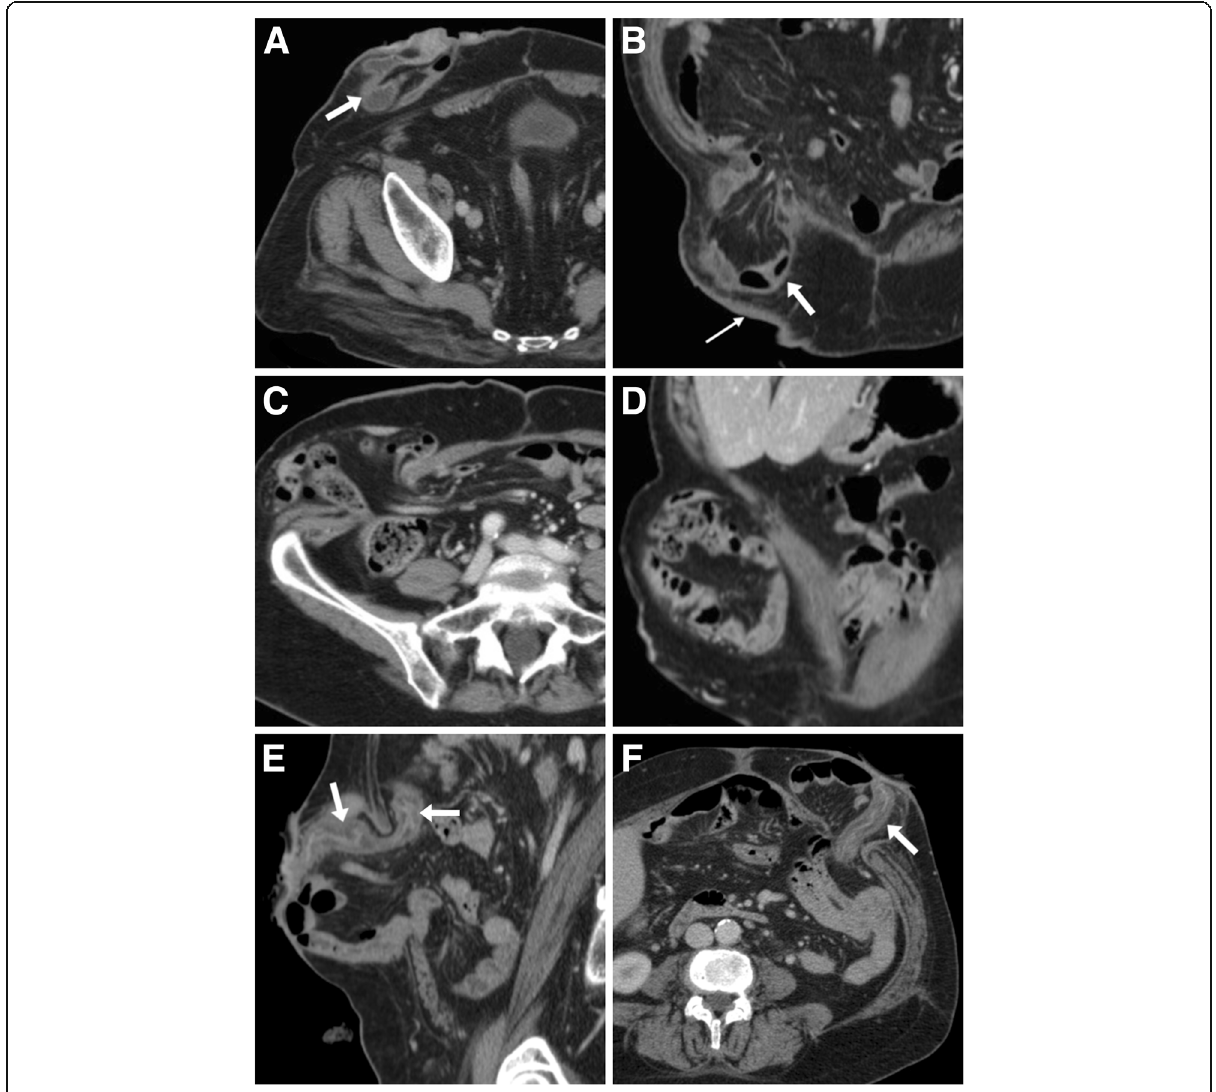
Fig. 14 Three cases of uncomplicated PH. a , b CT type Ib PH measuring approximately 6 cm in size containing a redundant ileostomy tract (arrows). c , d Larger PH containing a large portion of the right colon. e , f Type III PH following recent Hartmann ’ s surgery containing the oedematous colostomy tract (arrows) and some small bowel